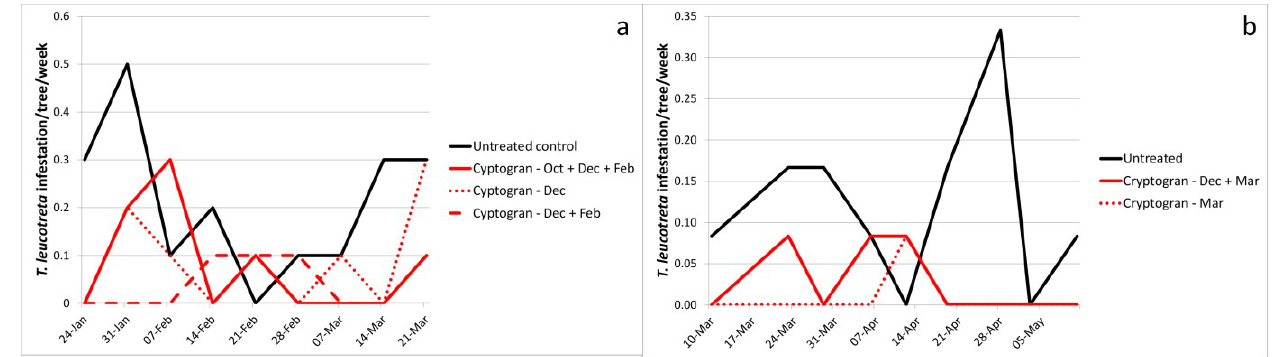
Figure 5. Thaumatotibia leucotreta -infested fruit per tree per week at ( a ) Dunbrody Farm. The trial was sprayed on 26 October and 5 December 2006 and 5 February 2007; ( b ) Welgelegen Farm. The trial was sprayed on 8 December 2009 and 15 March